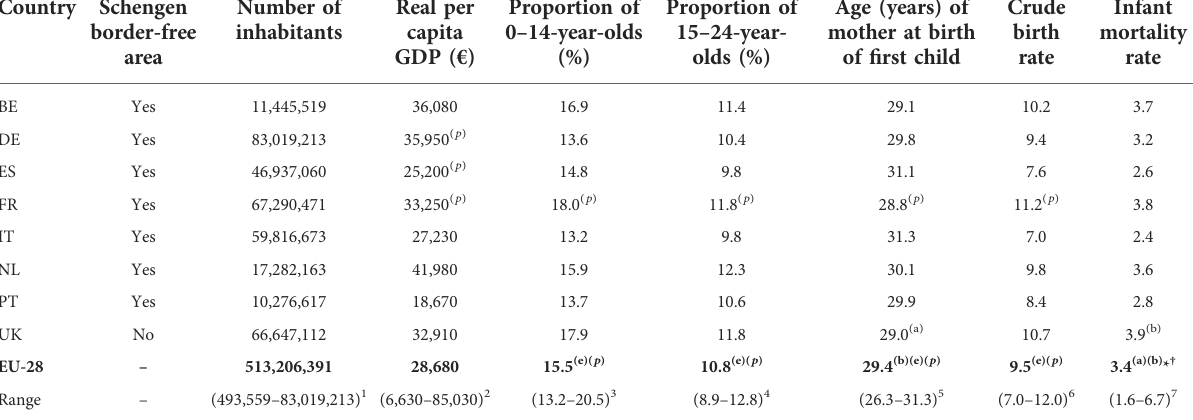
TABLE 1 Economics and demographic characteristics of the 8 selected countries in 2019 (22). Country